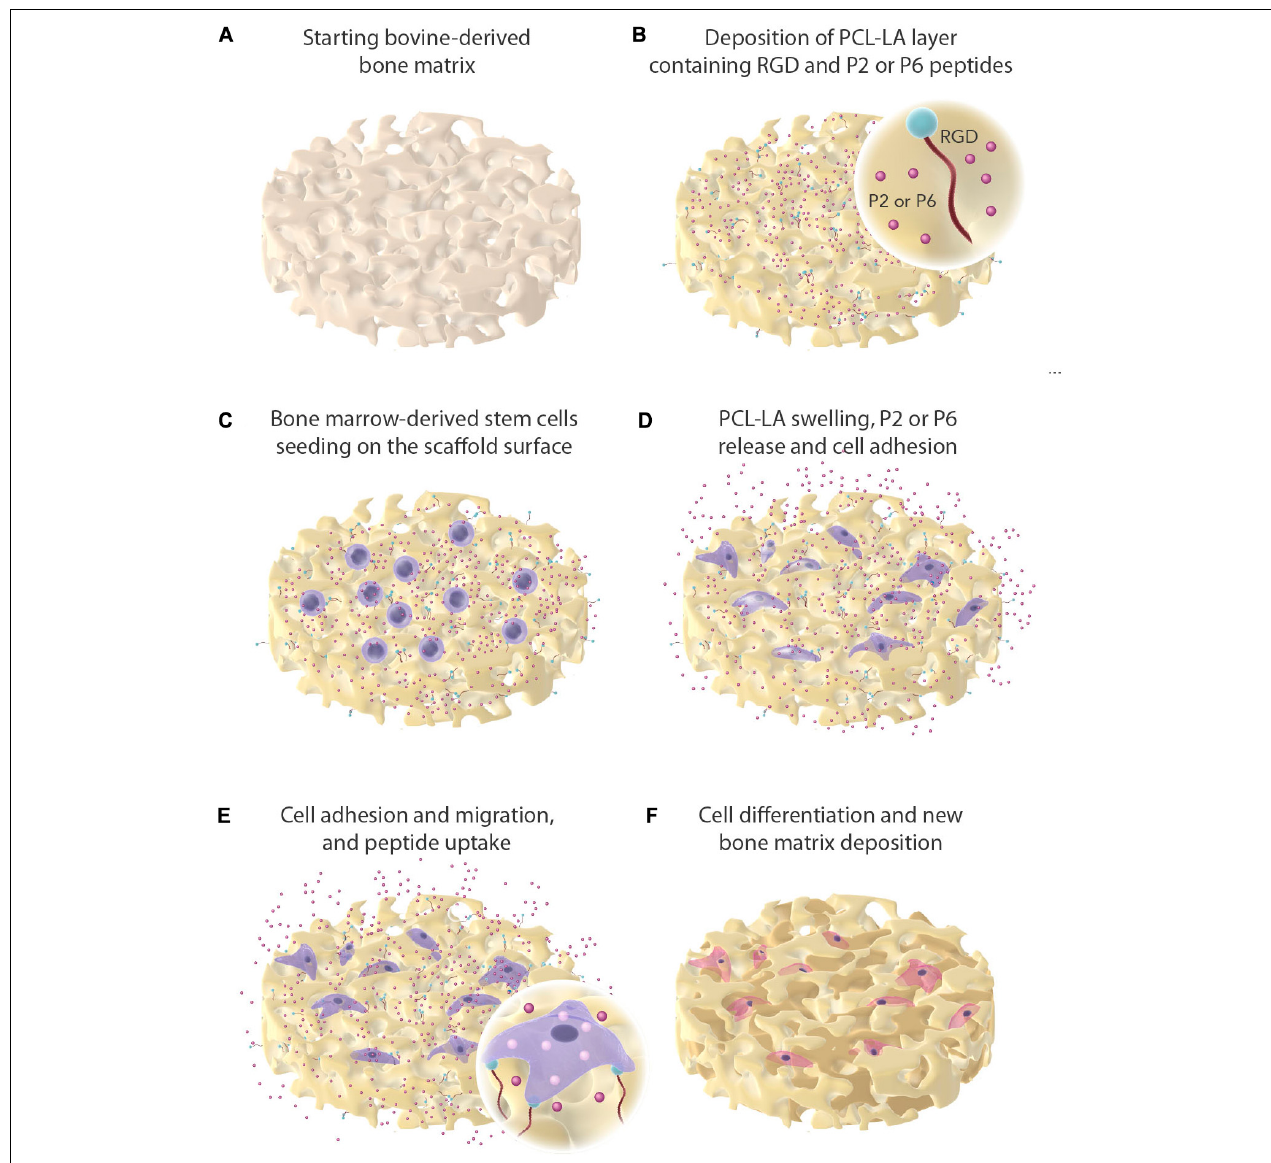
FIGURE 1 | Graphical overview of experimental work. Dissolved and physical entrapment of P2 and P6 in a polymer matrix (PCL-LA) and mesenchymal stem cells seeded onto the bone graft. The peptides are presented as red sphere and are being released off the bone graft as the PCL-LA